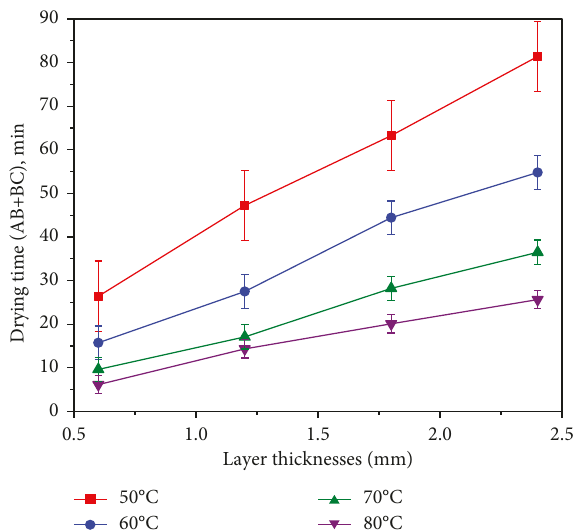
Figure 4: Variation of drying time with the thickness of the spent coffee grounds layer.